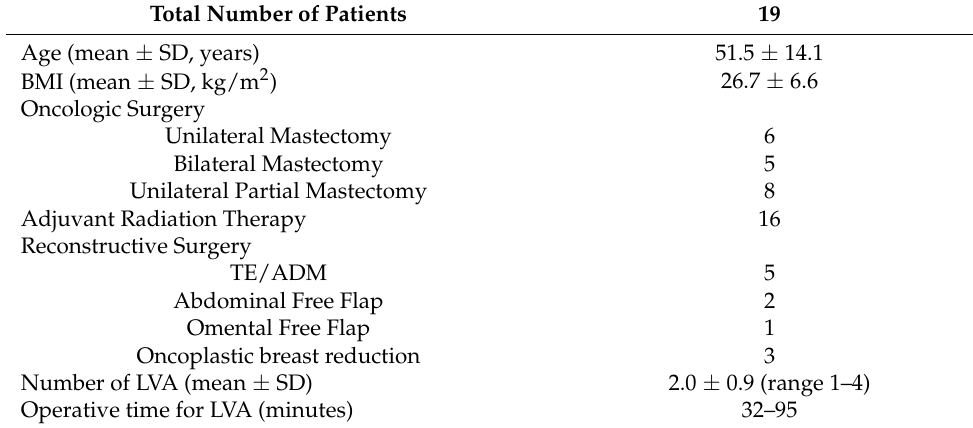
Table 1. Patient Demographics.